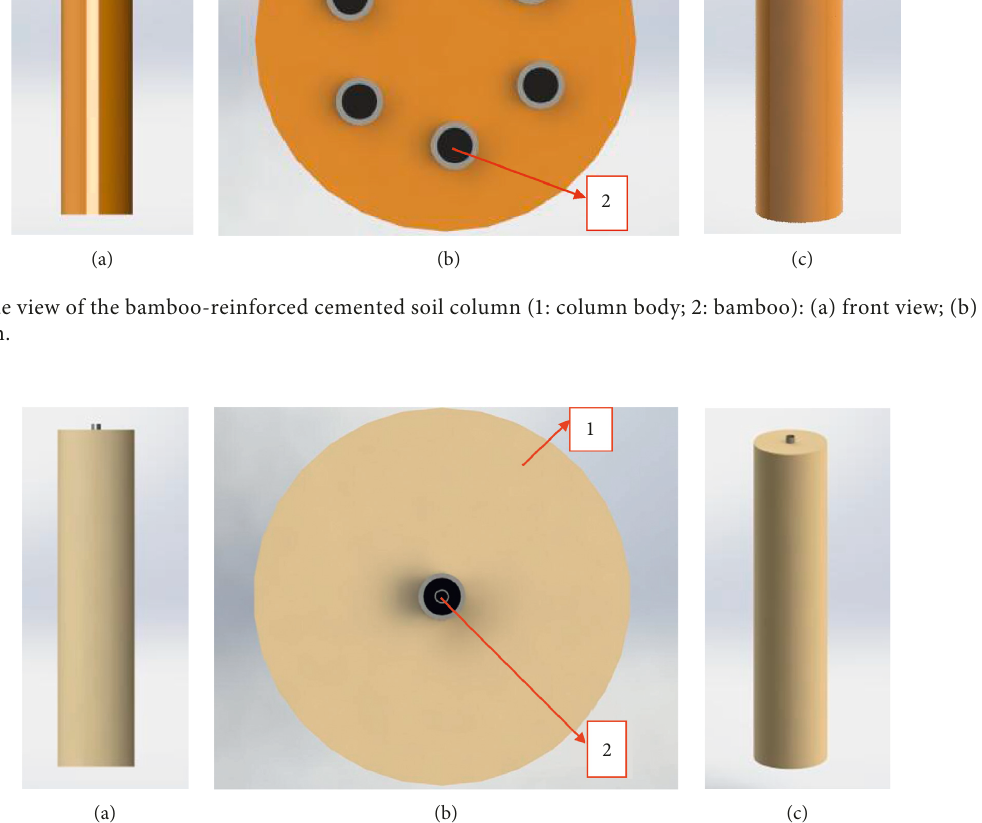
Figure 20: Schematic diagram of the freezing-cemented soil column (1: column body; 2: freezing pipe): (a) front view; (b) plan view; (c) spatial pattern.